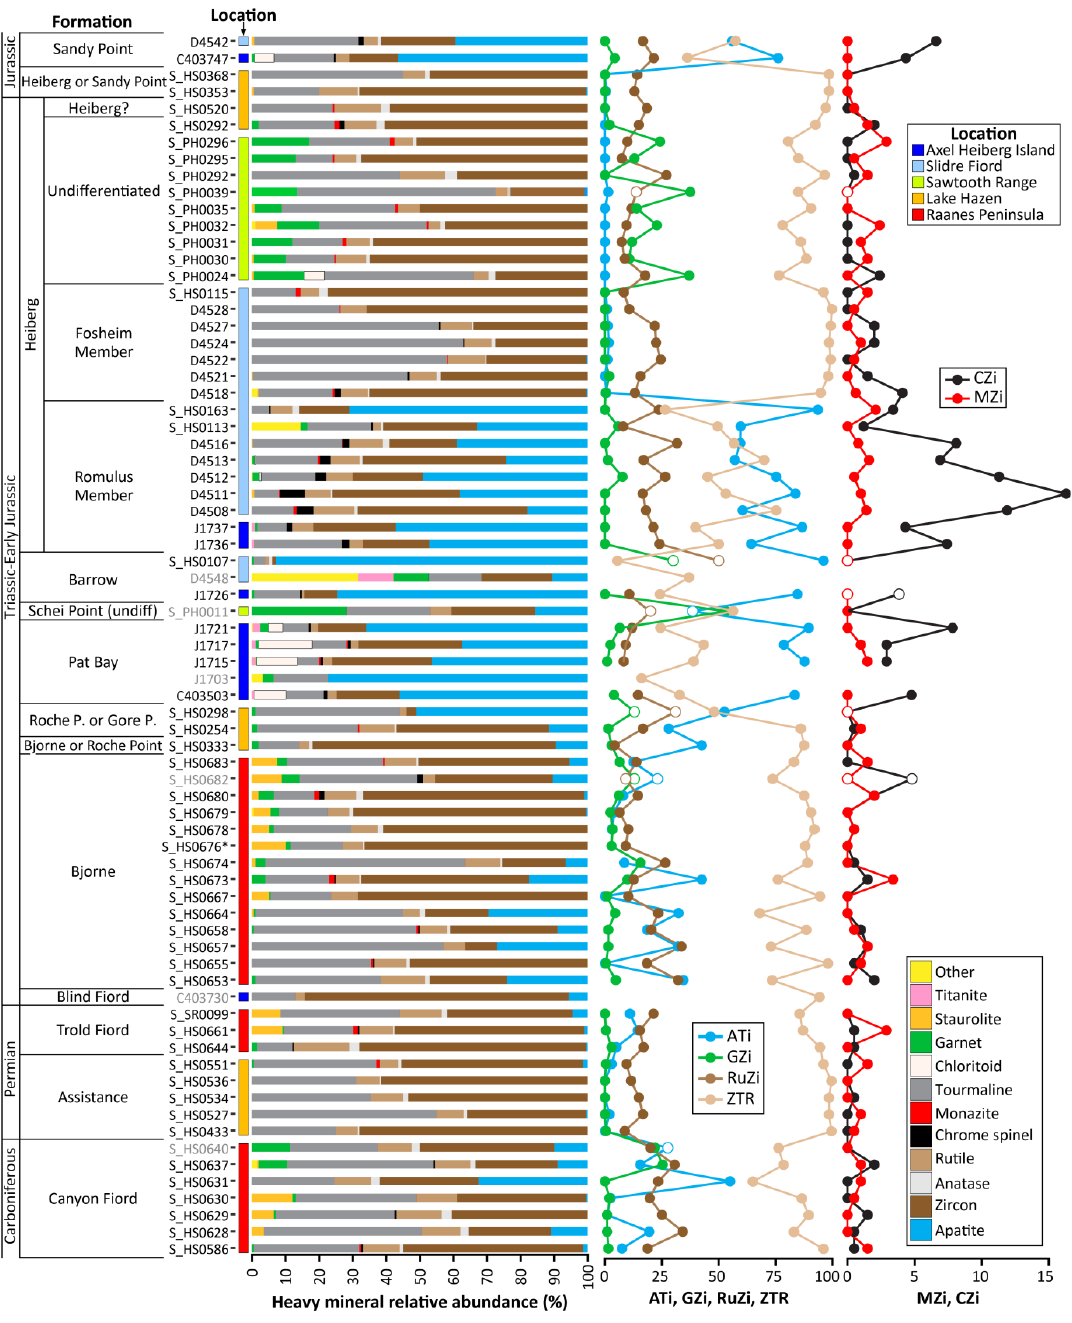
Figure 5. Conventional heavy mineral data. The relative abundances of the transparent heavy minerals are illustrated as bar charts. Sample numbers in grey indicate assemblages based on <100 counts. *Sample S_HS0676 was treated with hydrochloric acid prior to counting because of overwhelming amounts of carbonate minerals; unfortunately, this treatment also removed phosphate minerals including apatite. Minerals plotted as “other” comprise calcic amphibole, clinopyroxene, epidote, gahnite, kyanite and orthopyroxene. Provenance sensitive indices are illustrated as line graphs. ATi = apatite:tourmaline index, GZi = garnet:zircon index, RuZi = rutile:zircon index, MZi = monazite:zircon index and CZi = chrome spinel:zircon index (after [91]). ZTR index = sum of zircon, tourmaline and rutile as a percentage of total transparent heavy minerals. Open circles denote provenance sensitive index values based on fewer than 30 counts. Data from samples C403730, C403503 and C403747 are redrawn from Omma et al. [34].